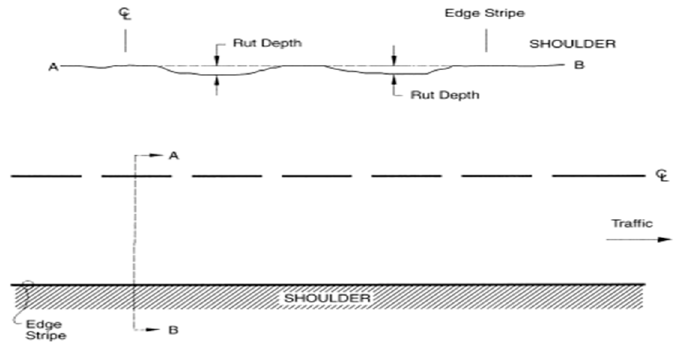
Figure 1. Top view and Cross-Sectional View of Ru tt ing depth.